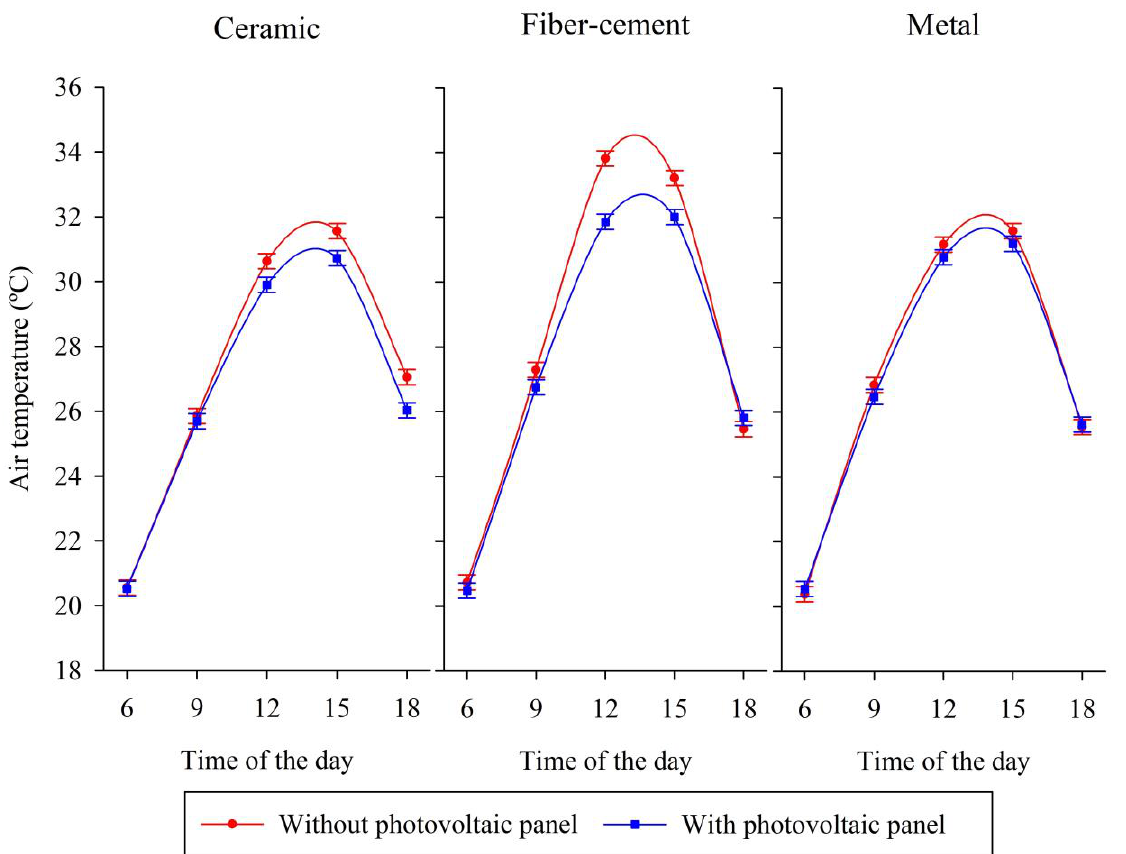
Figure 2. Behavior of the air temperature values inside the prototypes with the three types of tiles (ceramic, fiber-cement, and metallic) with the absence and presence of the photovoltaic panel. It is observed in Figure 2 that the air temperature for all types of tiles analyzed was higher at the hottest times of the day, between 12:00 and 15:00 h, especially in the case of roofs without the application of the photovoltaic panel. In the prototypes with ceramic tile, the average value of air temperature at 12:00 h was 30.6 ◦ C and at 15:00 h it was 31.6 ◦ C, while in the prototypes with ceramic tiles and photovoltaic panels these values were 29.9 and 30.7 ◦ C, respectively. The differences in air temperature values between the prototypes with the absence and presence of a photovoltaic panel were around 0.7 ◦ C at 12:00